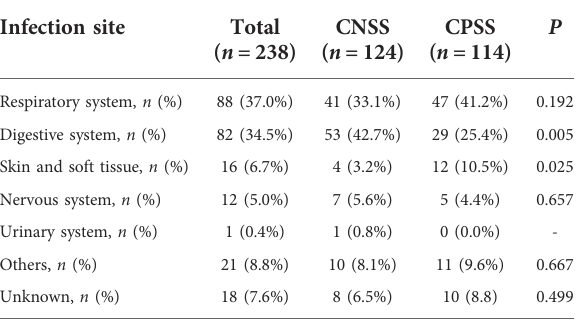
TABLE 4 Primary infection sites.